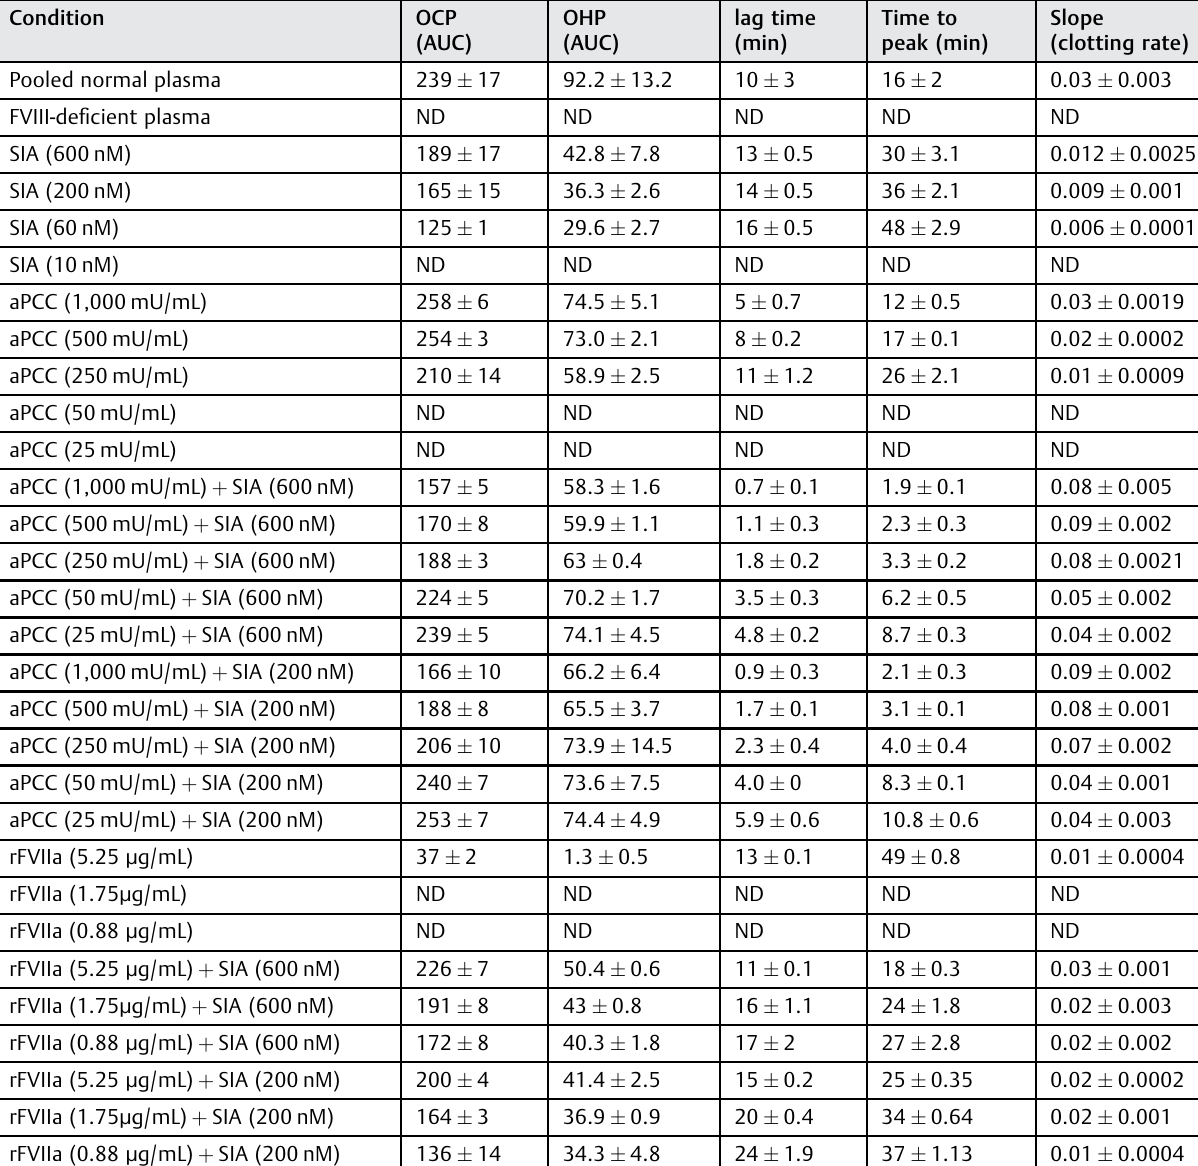
Table 1 OHP and turbidity assay parameters